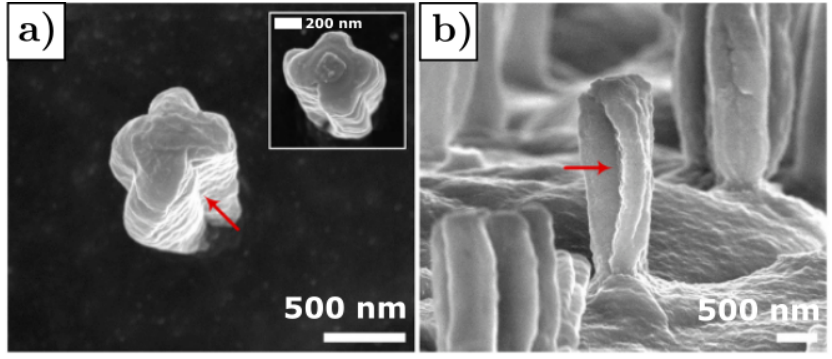
Figure 5. SEM images showing cracks in silicon nanowire, pointed out by the red arrow. ( a ) Top view and ( b ) Side view. Reprinted with permission from [54], Copyright 2012.